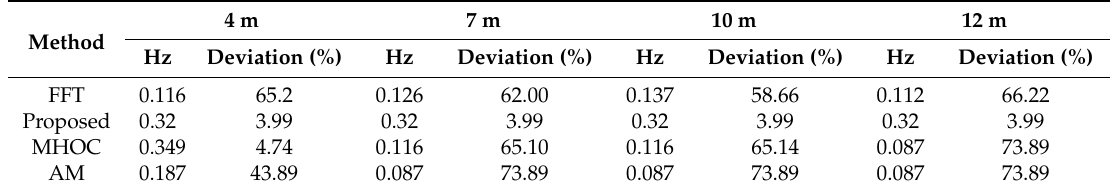
Figure 15. The selected signals in the interested region based on the acquired data from the actuator at distances of ( a ) 4 m; ( b ) 7 m; ( c ) 10 m; and ( d ) 12 m indoors. Table 3. Frequency estimates with the two methods. FFT: Fourier fast transform.